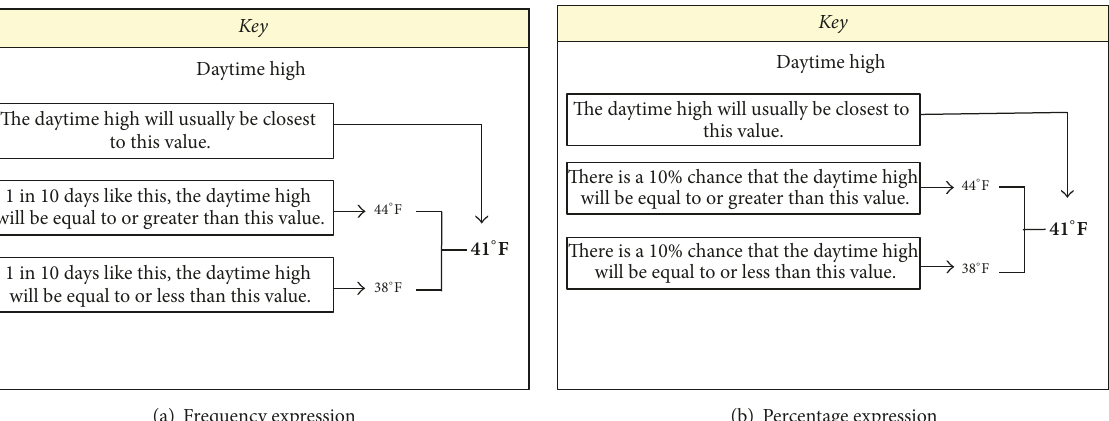
Figure 7: Keys used to explain the predictive interval in Experiment 2. Font sizes are slightly smaller in this figure than they were in the experiment to conform to journal